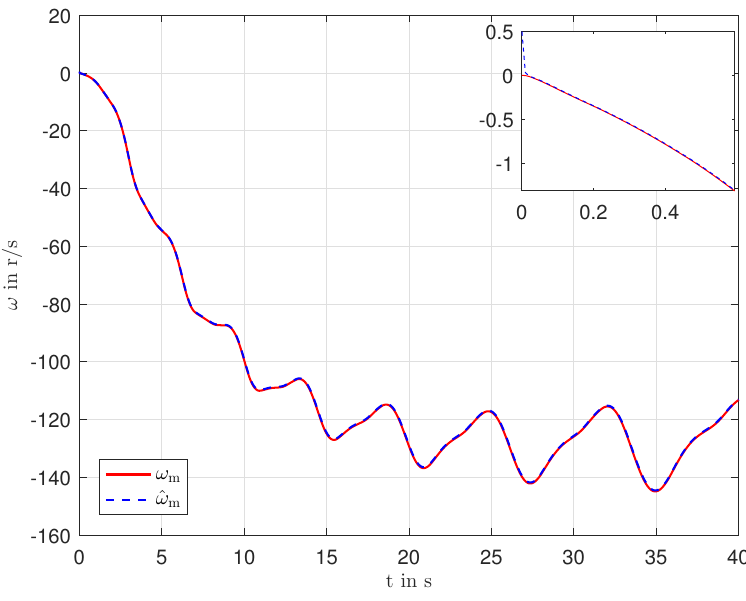
Figure 6. Measured and estimated IM speeds. The performance of the field oriented control of the IM is demonstrated in Figure 7 and 8. The tether force F T exerted on the winch is shown in Figure 9. During the traction phase, F T drives the IM, which operates as a generator to produce electricity. According to (9) and Table 1, T r = T wc /12 and T e = T wi /12. Therefore, the results in Figure 7 show that the torque controller accurately keeps the induced torque T e of the IM to the desired level T r . Similarly, the rotor flux φ dr successfully tracks the optimal flux trajectory φ opt , cf. Figure 8. The electrical angle θ e in (18), which is used for the transformation from SRF to SRRF and vice-versa is shown in Figure 10. The 2 − φ control voltages of the torque ( u qs ) and flux ( u ds ) PI controllers are shown in Figure ?? , and the corresponding 3 − φ control voltages are shown in Figure 12. The proportional and integral gains for the torque and = 100, k = 6000, k = 100, and k = 6000, respectively. It can flux PI controllers are k p p φ i T i φ T be seen in Figure 7 and 8, that RFOC makes the instantaneous control of both torque and flux